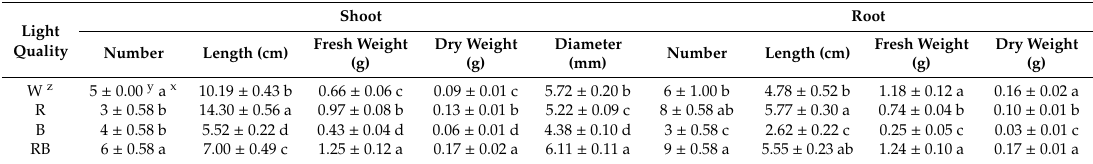
Table 2. E ff ect of light quality on growth and development of C. triste plantlets after four weeks of culture. Shoot Root Light Quality